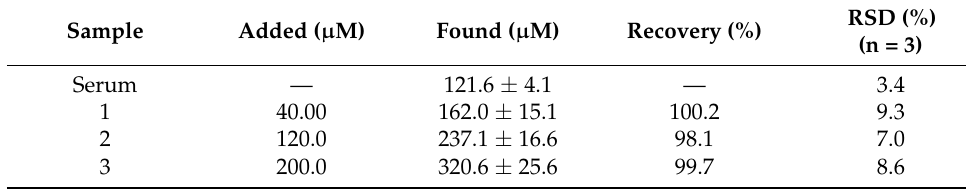
Table 1. Recovery of lactate in human serum with Alg@PDCN@QDs-LOx MSs.